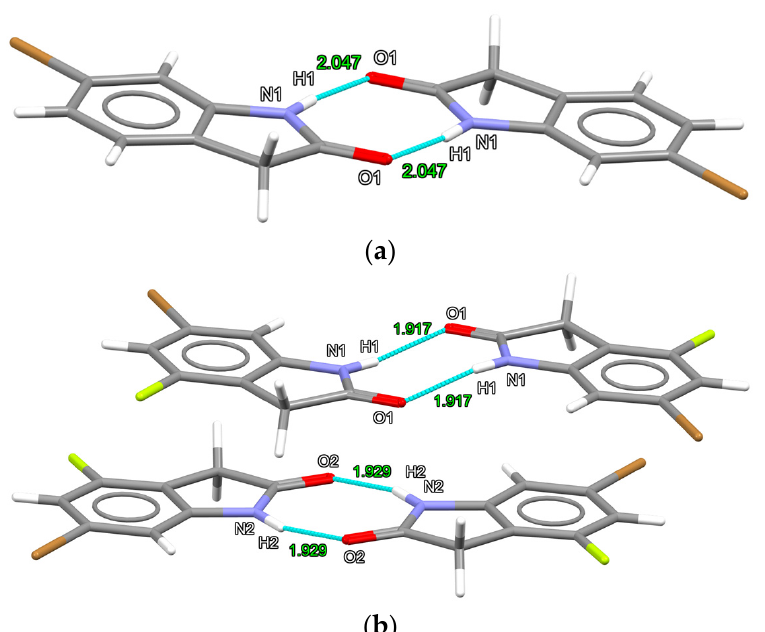
Figure 2. R2,2(8) hydrogen bonding dimers in structure 1 ( a ) and structure 2 ( b ). Intermolecular atom distances in units of Å.